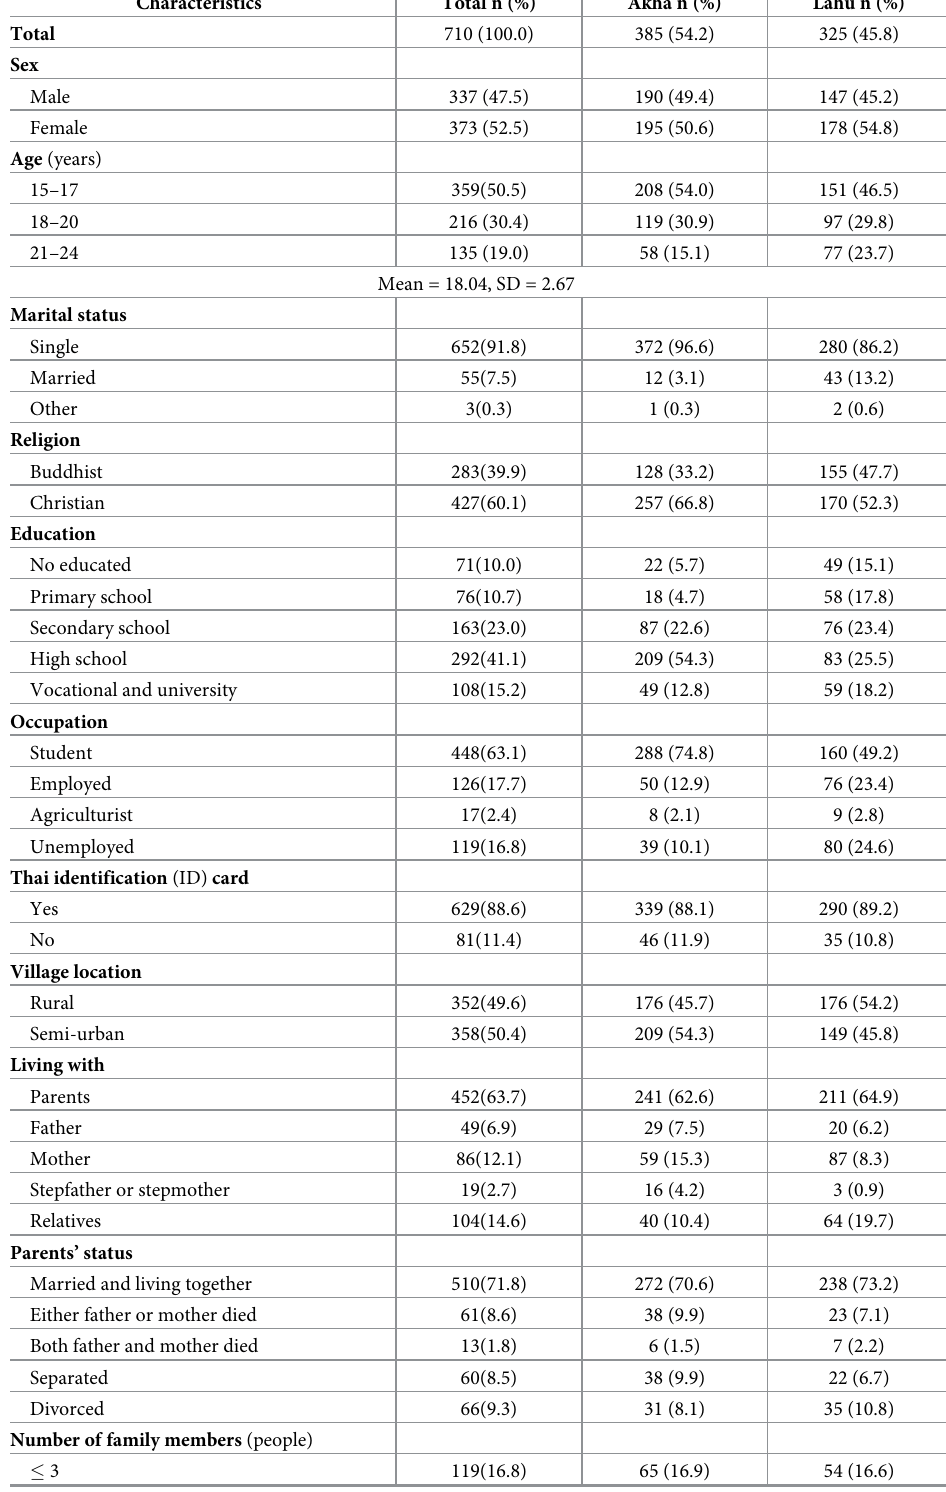
Table 1. General characteristics of the